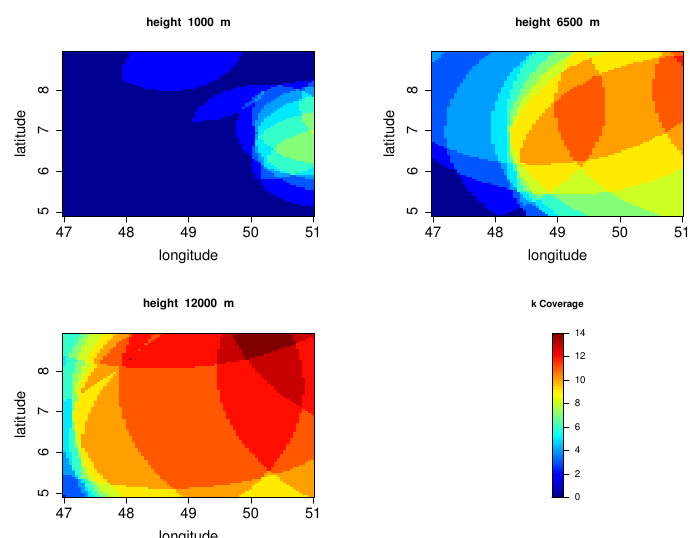
Figure 1. Simulated k-coverage heatmap for a random placement of n = 30 automatic dependent surveillance–broadcast (ADS-B) sensors.